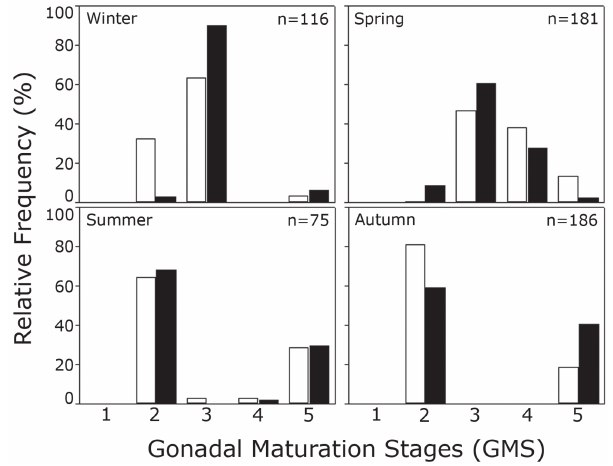
Fig. 3. Seasonal variation in percent (%) frequency of occurrence of gonad maturation stages (GMS) for females (white column) and males (black column) of Cetengraulis edentulus in Guanabara Bay.